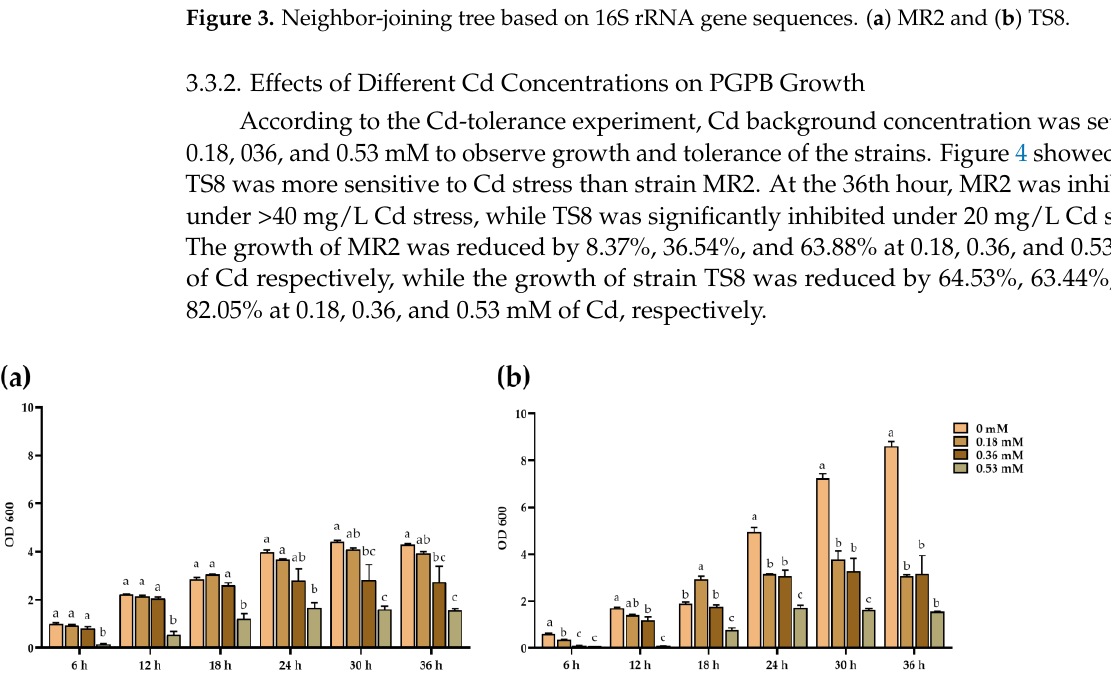
Figure 4. Optical density of selected bacteria at 0, 0.18, 0.36, and 0.54 mM Cd concentration during different incubation times. ( a ) MR2 and ( b ) TS8. The data were expressed as means ± standard deviation ( n = 3). Different letters represent significant differences of absorbance between different Cd concentrations between groups at the 5% level (ANOVA and Tukey’s test).